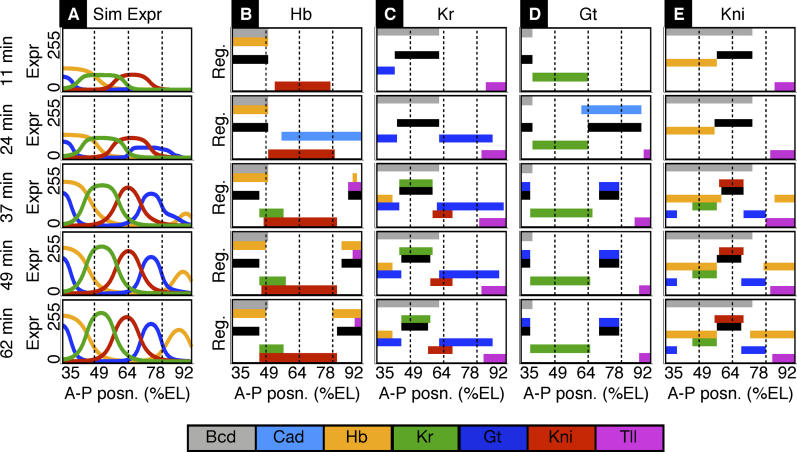
Simulated Gap Gene Expression, Production, and Regulatory Effects in the Unc-Logic ModelIn each plot in columns B–E, the black bar indicates the spatial extent of production. Colored bars above the black bar represent regions in which the corresponding activatory input is above threshold (at least one activator must be above threshold for production to occur). Colored bars below the black bar represent regions in which the corresponding repressive input is above threshold (production only occurs if no repressors are above threshold).